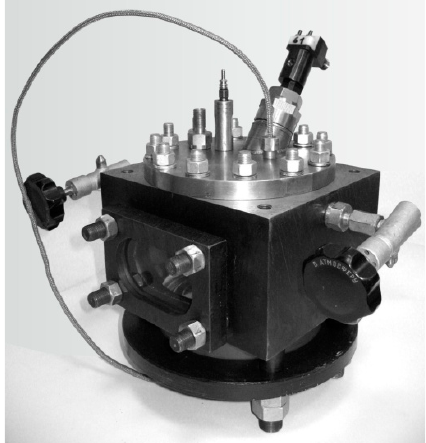
Figure 6. Photograph of the constant volume chamber.